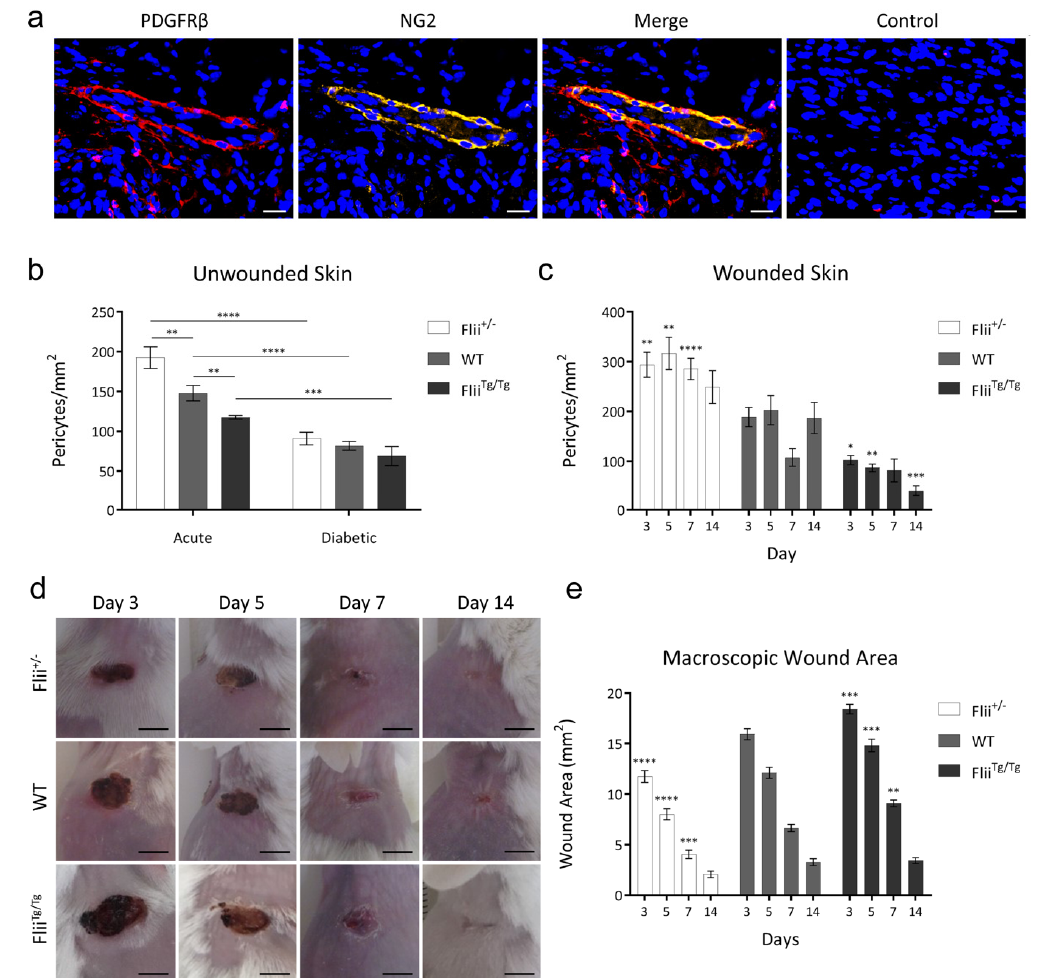
Figure 3. ( a ) Dual PDGFR β /NG2 pericyte staining in 4 μ m sections of paraffin-embedded murine tissue. No primary antibody-stained section is shown as control. Composite images taken at 20× objective, scale bar = 20 μ m. ( b ) PDGFR β /NG2 + pericyte numbers in acute and diabetic unwounded skin of Flii +/ − , WT and Flii Tg/Tg wounds. Data displayed as mean ± SEM, n = 6. ( c ) PDGFR β /NG2 + pericyte numbers in diabetic Flii +/ − , WT and Flii Tg/Tg wounds. Data displayed as mean ± SEM, n = 8. ( d ) Flii +/ − , WT and Flii Tg/Tg diabetic excisional wounds collected at 3, 5, 7 and 14 days post-injury. Scale bar = 5 mm. ( e ) Macroscopic wound area of Flii +/ − , WT and Flii Tg/Tg diabetic excisional wounds. Data displayed at mean ± SEM, n = 8. Statistical significance was calculated using a two-way ANOVA where * = p < 0.05, ** = p < 0.01, *** = p < 0.001, **** = p <